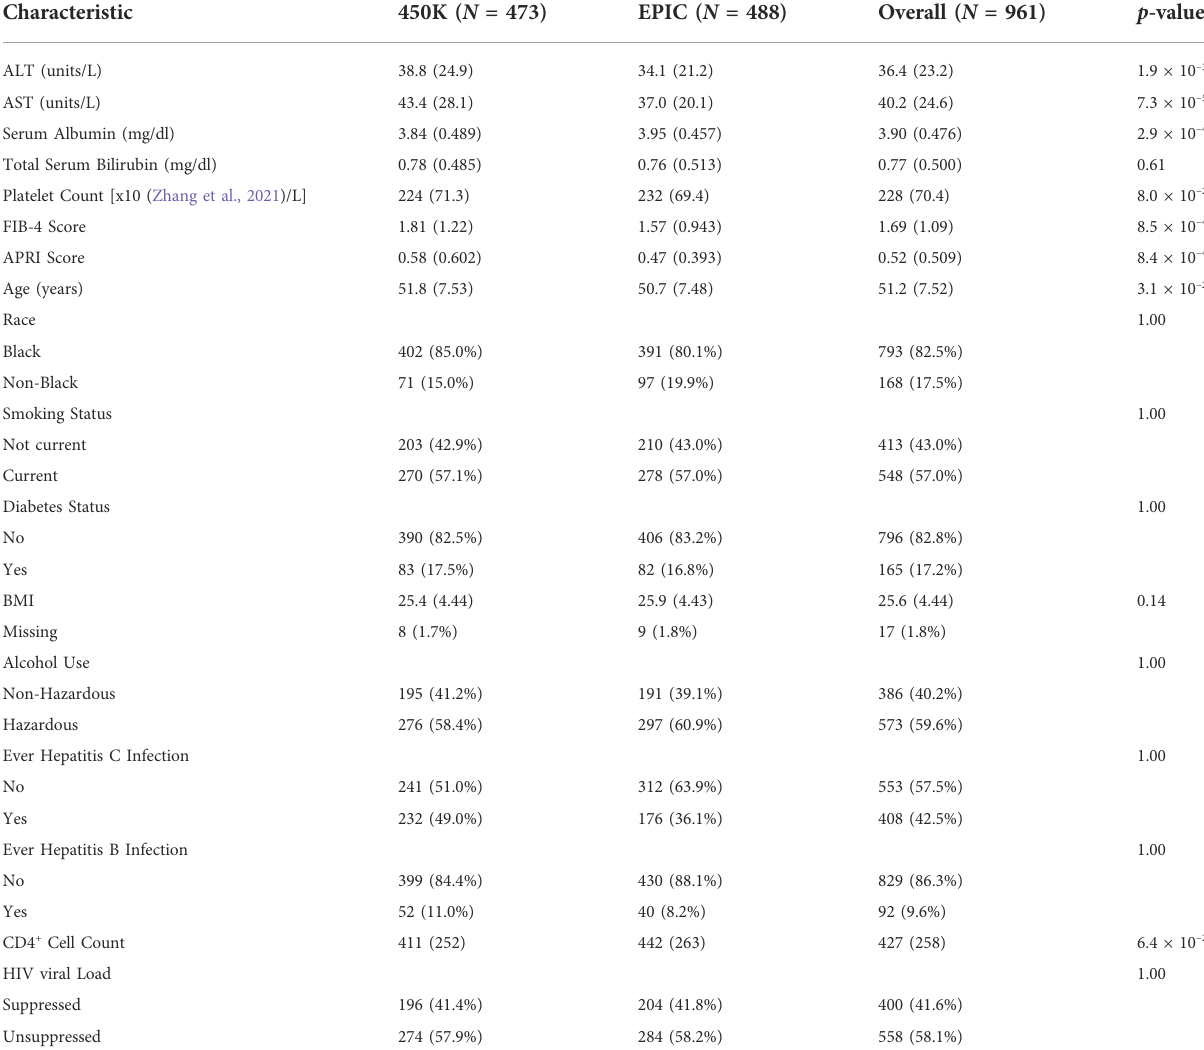
TABLE 1 Characteristics of participants grouped by platform used for genome-wide DNA methylation.